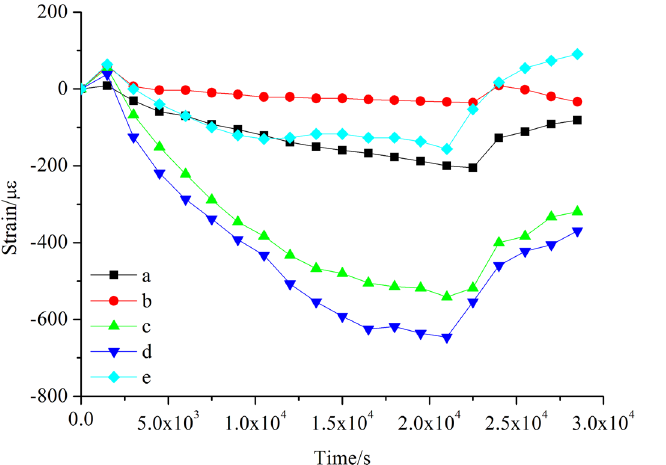
Figure 9. Strain–time relationship for steel tube inner